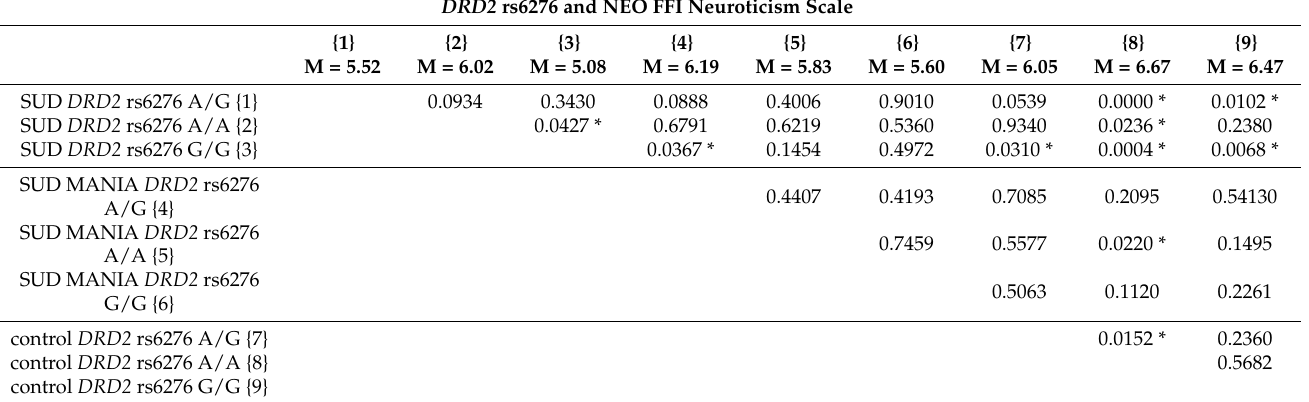
Table 6. Post hoc analysis of dependences between patients diagnosed with polysubstance use disorder comorbid with a maniacal syndrome (SUD MANIA)/control and DRD2 rs6276 and NEO FFI Neuroticism scale. DRD2 rs6276 and NEO FFI Neuroticism